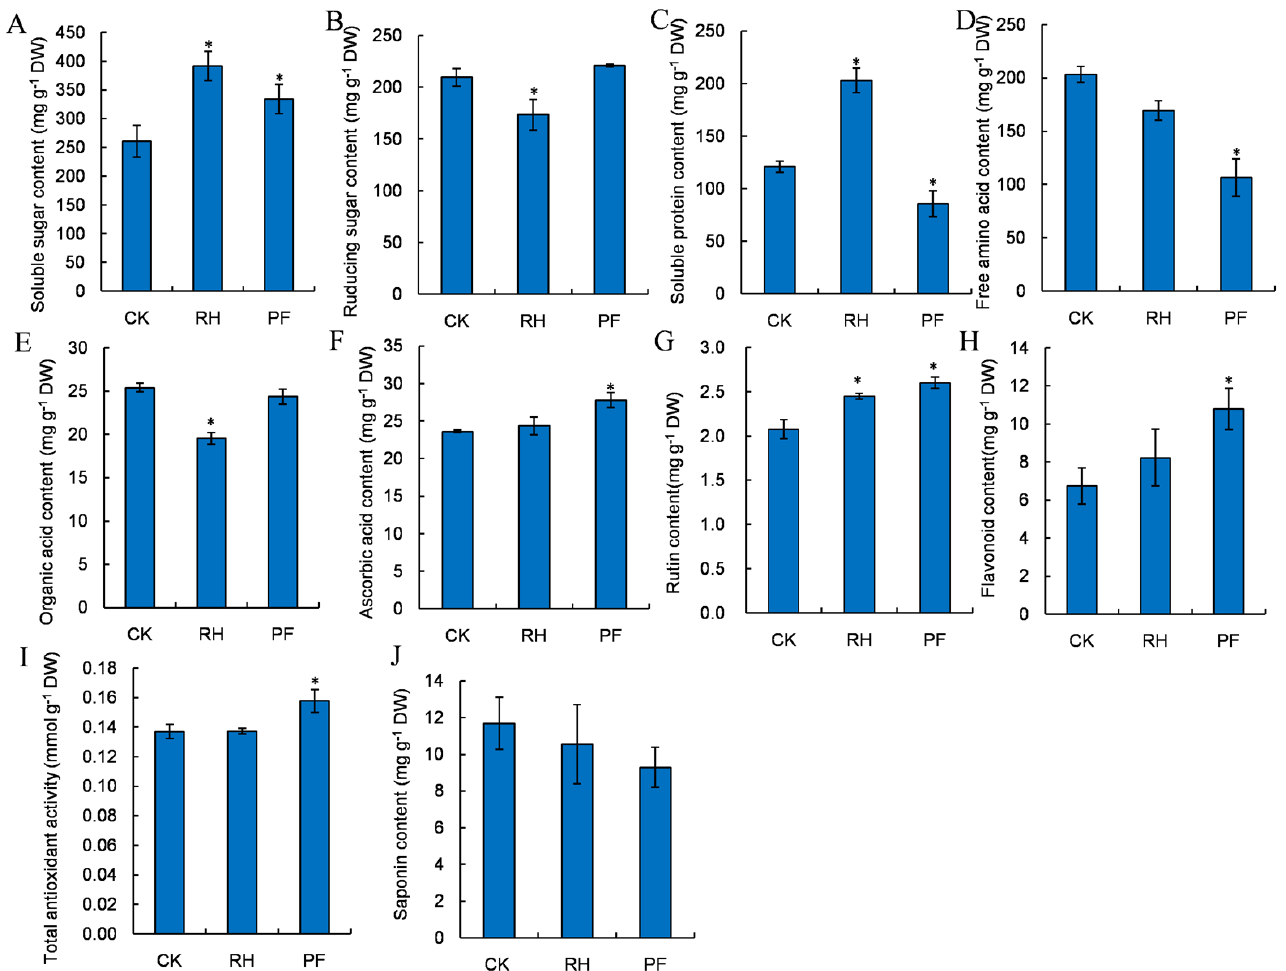
Figure 3. Comparison of the nutritional quality of spears under various mulching methods. Content of soluble sugar ( A ), reducing sugar ( B ), soluble protein ( C ), free amino acid ( D ), organic acid ( E ), ascorbic acid ( F ), rutin ( G ), and flavonoid ( H ). Total antioxidant activity ( I ) and saponin content ( J ) of spears. CK: non-mulching control treatment; RH: rice-husk mulch; PF: plastic film mulch. DW: dry weight. Asterisks indicate significant differences from the CK at p < 0.05 (student’s t